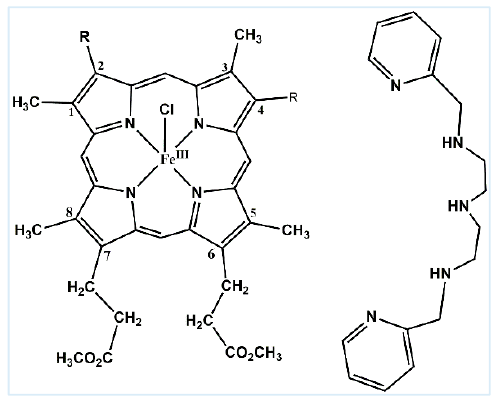
Figure 5. Precursors of the Fe(III)-dimethyl ester porphyrin and 1,9-bis-(2-piridyl)-2,5,8-triazanonane (Picdien). Protoporphyrin R = –CH=CH 2 , Mesoporphyrin R = –CH 2 –CH 3 , Deuteroporphyrin-H.